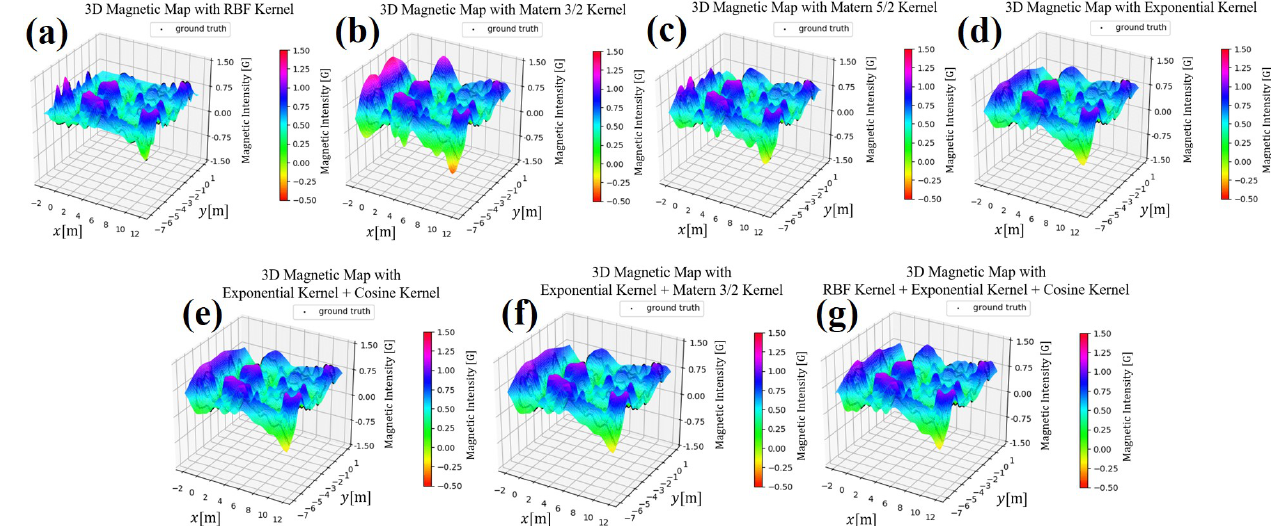
Figure 5. Magnetic map in the experimental environment. The strength is indicated by the color bar on the RGB scale. ( a ) RBF Kernel ( b ) Exponential Kernel ( c ) Matern 3/2 Kernel ( d ) Matern 5/2 Kernel ( e ) Exponential + Cosine Kernel ( f ) Exponential + Matern 3/2 Kernel ( g ) RBF + Exponential + Cosine